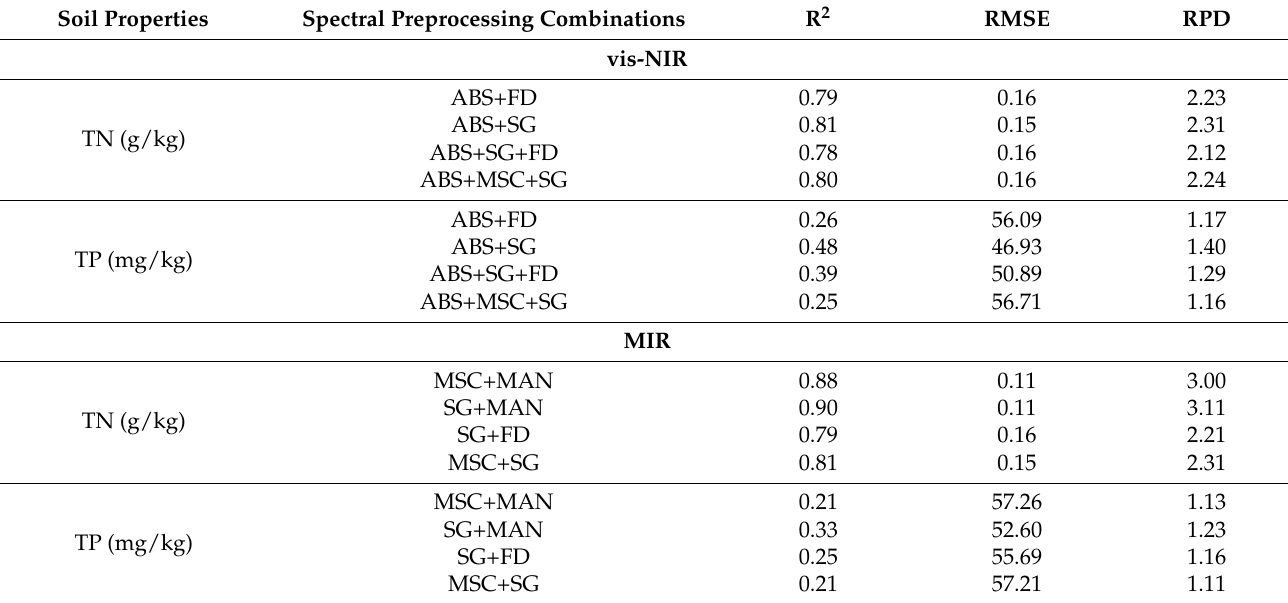
Table 3. Prediction accuracy of soil properties based on vis-NIR and MIR with different spectral pre-processing combinations.